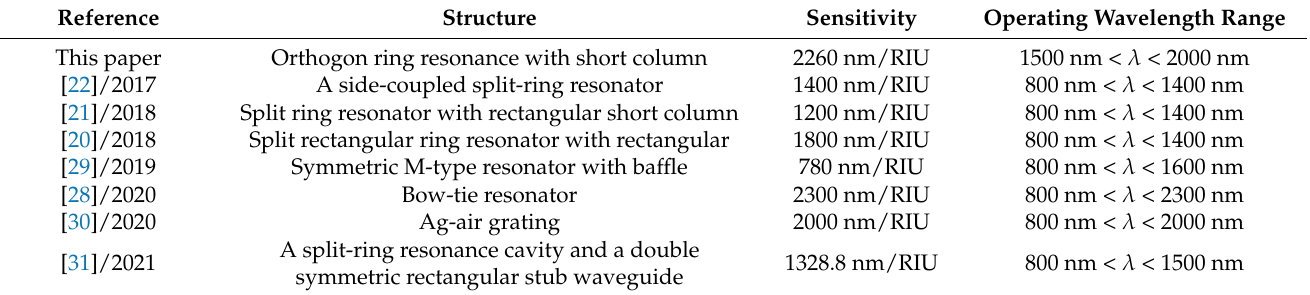
Table 1. Comparison with data from other literature.